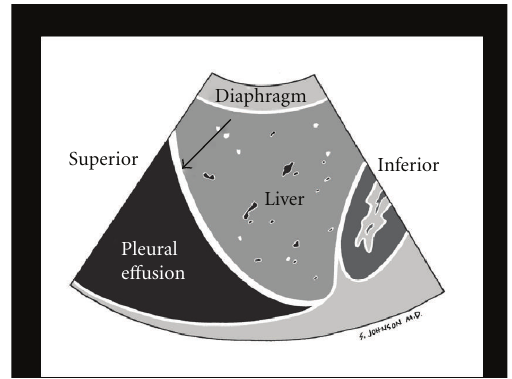
Figure 20: Normal lung.